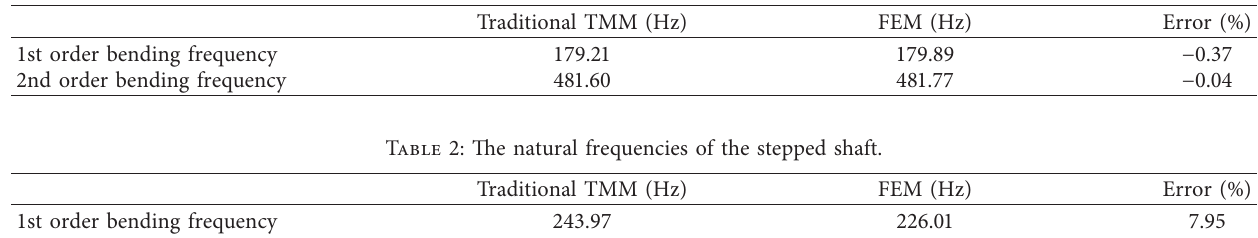
Table 1: The natural frequencies of the equidiameter shaft.